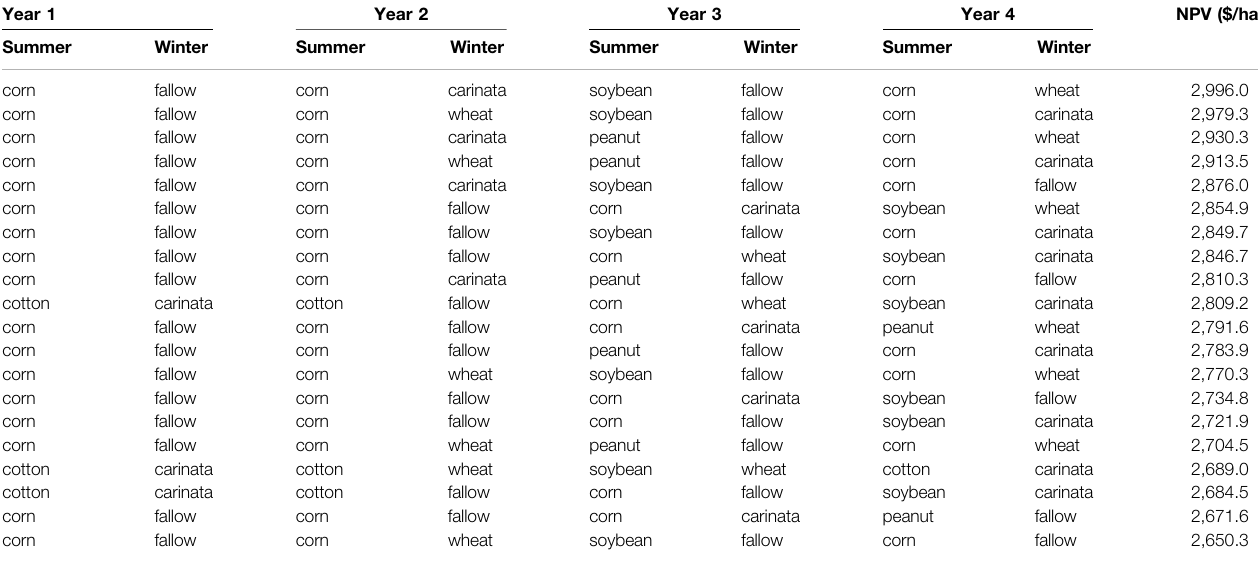
TABLE 3 | Top 20 crop rotations with the highest NPV under S1 and S3 when carinata prices are